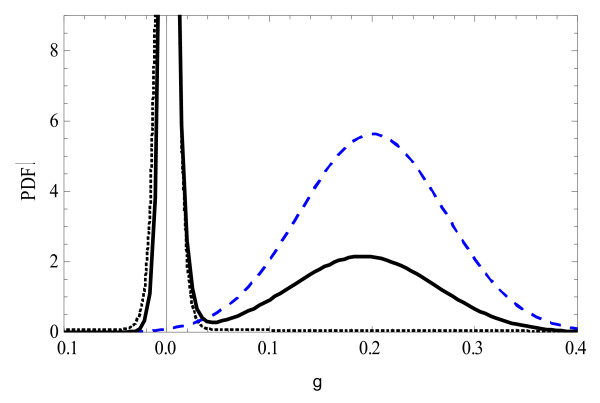
The probability density function (PDF) of the prior (...), likelihood (_ _ _), and posterior (___) of g. The parameter from the exponential distribution λ = 1.67, γ = 0.1, and Y = 0.2 (s.d. units); the spike of the prior distribution at zero is depicted by an exponential distribution, that is reflected around zero, with a very large λ of 200.